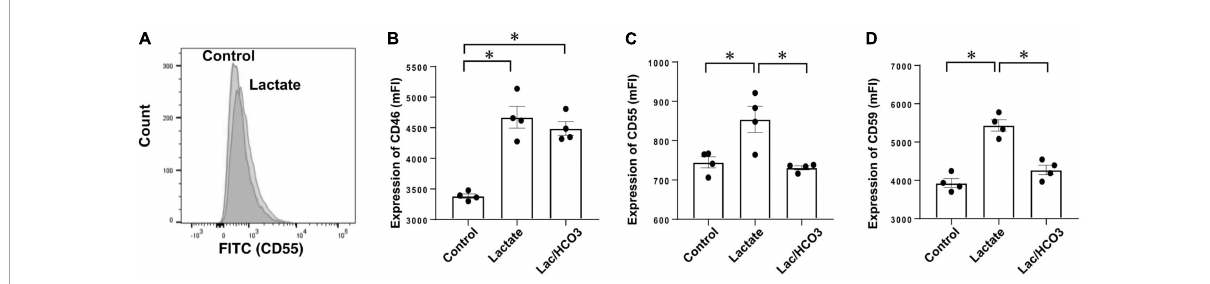
FIGURE6 Expression of membrane complement regulators (CRegs) of Met-5A stimulated with lactate. (A) Shows a sample of histograms for expression of CD55 stimulated by sodium lactate-added culture medium and control medium. (B–D) Show that stimulation with lactate increased expressions of CRegs on the cell surface of MeT-5A cells, while co-stimulation with lactate and bicarbonate did not show any significant change. In the group stimulated with sodium lactate, the concentration of lactate was set at 40 mmol/L, while in the group stimulated with both bicarbonate and sodium lactate, the respective concentrations were set at 25 and 15 mmol/L in culture medium. Those concentrations were determined with reference to Dianeal-N dialysate solution and Reguneal dialysate solution. ∗ P < 0.05.